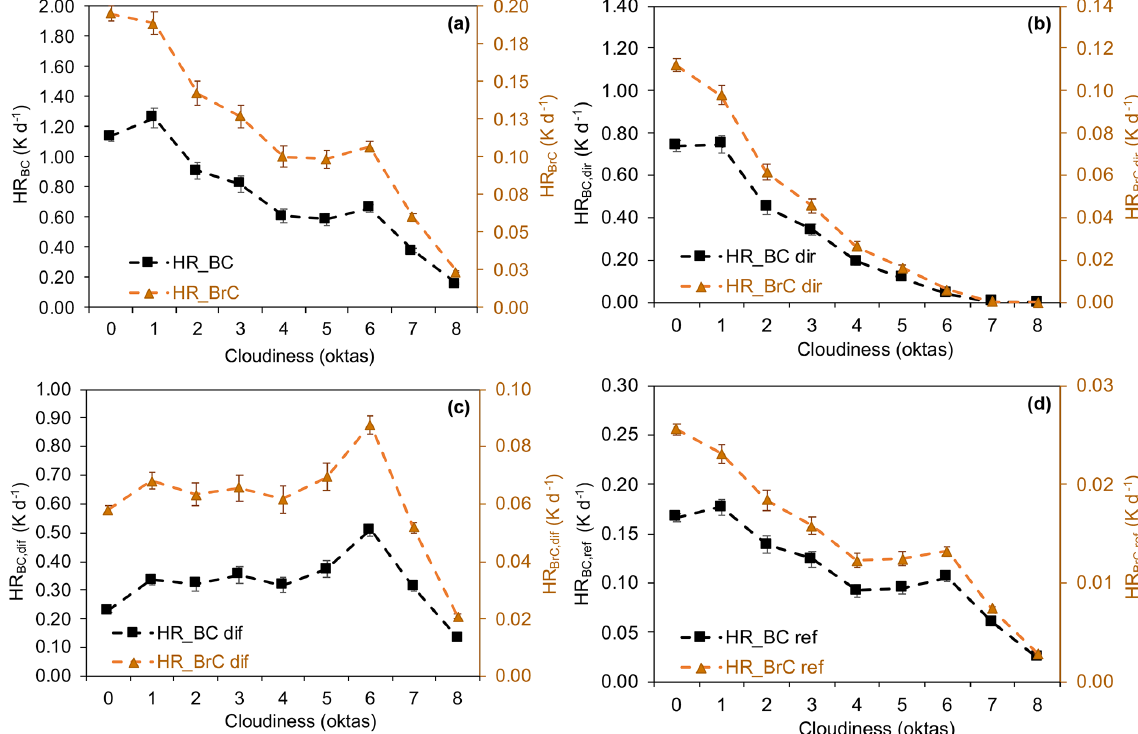
Figure 15. The HR of BC and BrC as a function of the cloudiness (oktas): (a) total HR BC and HR BrC , (b) direct component of both the HR BC and HR BrC (HR BC,dir and HR BrC,dir ), (c) diffuse component of both the HR BC and HR BrC (HR BC,dif and HR BrC,dif ), and (d) reflected component of both the HR BC and HR BrC (HR BC,ref and HR BrC,ref ). Note that, due to the different magnitude of the HR BC and HR BrC , the y axis of the HR BrC in the four panels was chosen as 1 / 10 of that of the HR BC